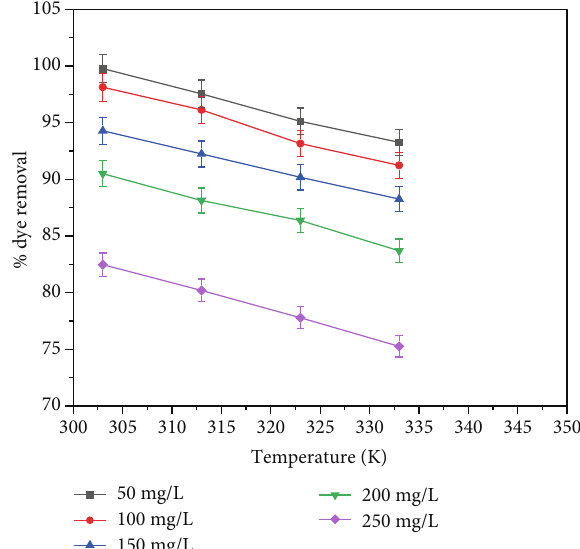
Figure 11: E ff ect of temperature on ARS dye removal.